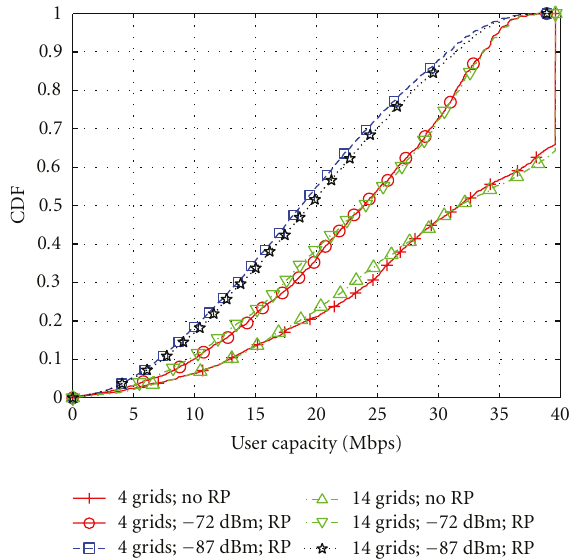
Figure 9: CDF showing downlink user capacity only for a ff ected femto UE for a system with resource partitioning compared against a system without resource